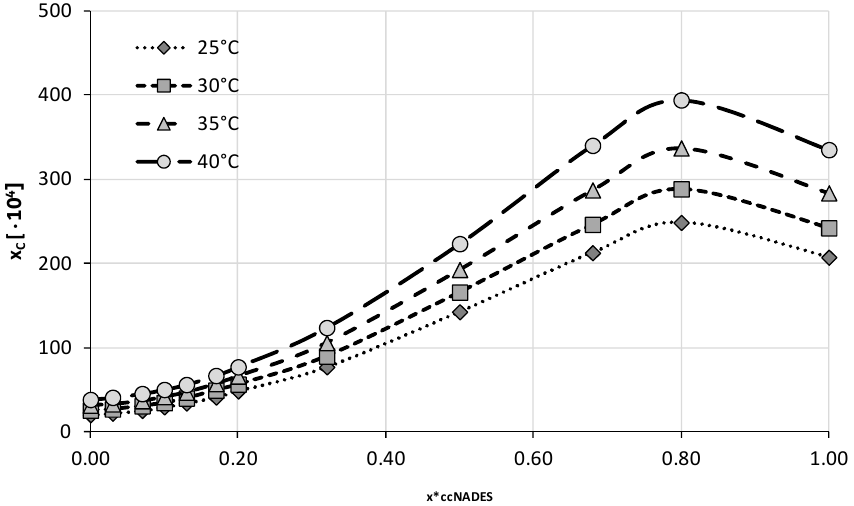
Figure 6. Mole fraction solubility of caffeine in mixtures of water and ccNADES comprising choline chloride and xylitol in 1:1 molar ratio. On the abscissa, x* ccNADES represents the mole fractions of the ccNADES in solute free binary solutions.